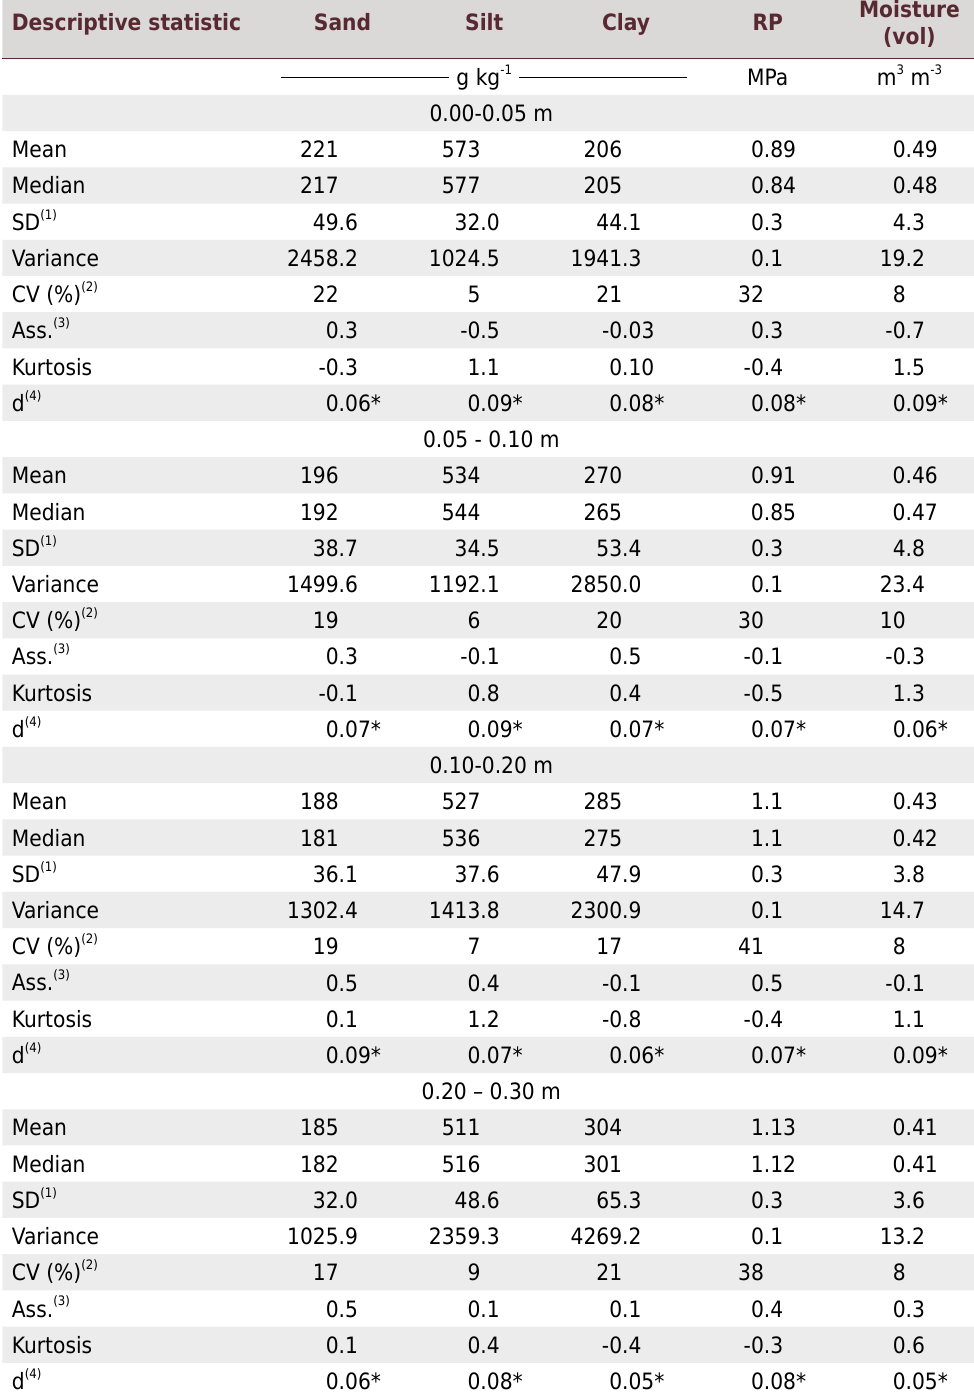
Table 2. Descriptive statistics for contents of sand, silt, and clay, as well as soil resistance to penetration (RP) and soil moisture, for four soil layers, in areas of Archaeological Dark Earth under cacao cultivation